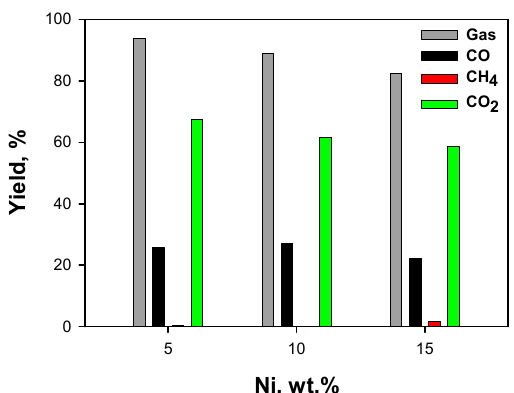
Figure 6. Gas yield and yields to CO, CH 4 , and CO 2 as a function of the Ni content during steam reforming of HB mixture at 720 °C and atmospheric pressure; gas-phase feed composition: Solvent/H 2 O/O 2 /N 2 = 0.7/6/0.8/92.5.